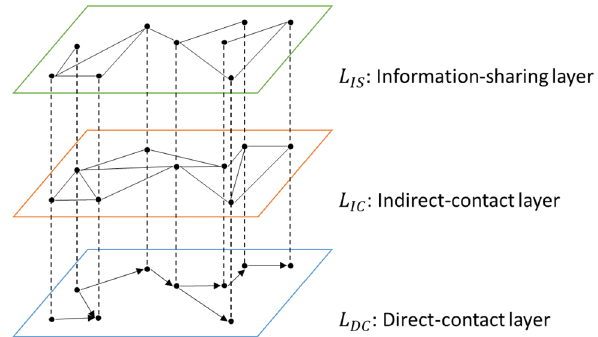
Figure 2. Multilayer network structure of FMD transmission among beef-cattle